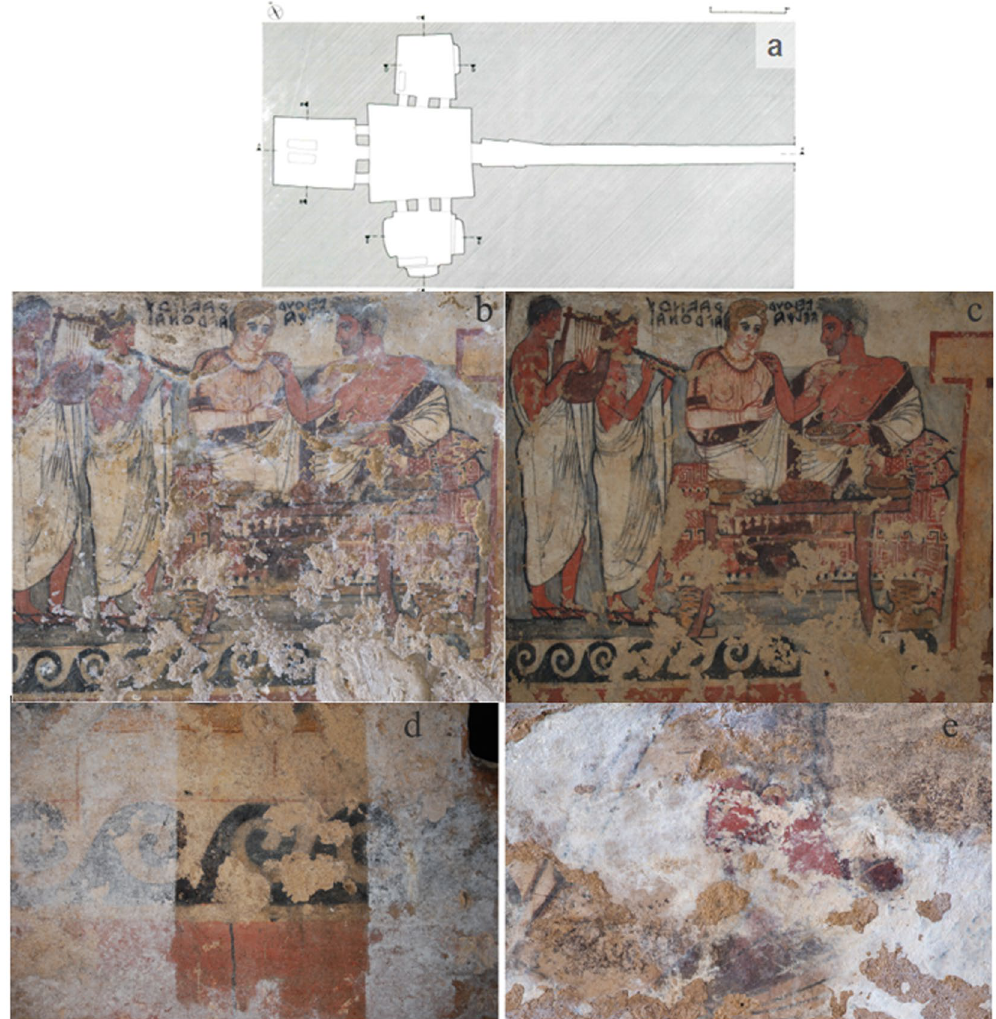
Figure 1. Tomba degli Scudi , Tarquinia, Italy. Intervention of the restorers to eliminate the white deposition (CaCO 3 ) which covers the walls. ( a ) Hand drawn map of the tomb from Maria Cristina Tomassetti, based on measures taken during the intervention of restoration. The restoration presented in this paper is referred to the central chamber; bar, 5 meter. ( b ) Northern wall before the intervention. ( c ) Northern wall after the elimination of CaCO 3 ; it is possible now read the names Ravnthu Aprthnai, on the left and Velthur Velcha, on the right. ( d ) Western wall, in the central part of the fresco the white deposition was eliminated as a tester for the restorers. ( e ) The thick patina in the eastern